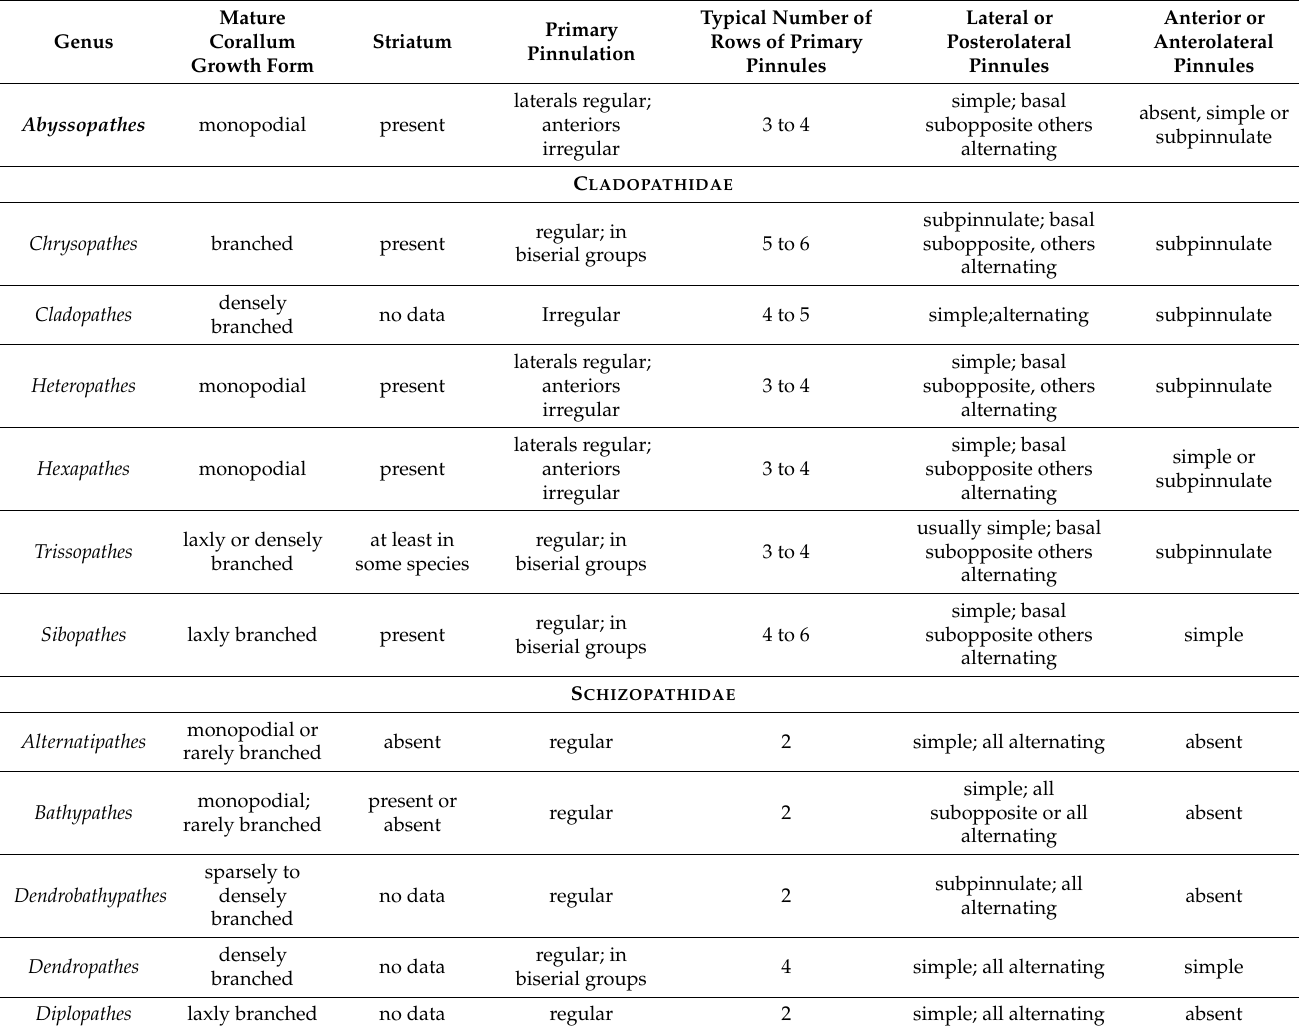
Table 1. Comparison of gross colony features of Abyssopathes Opresko, 2002, with other